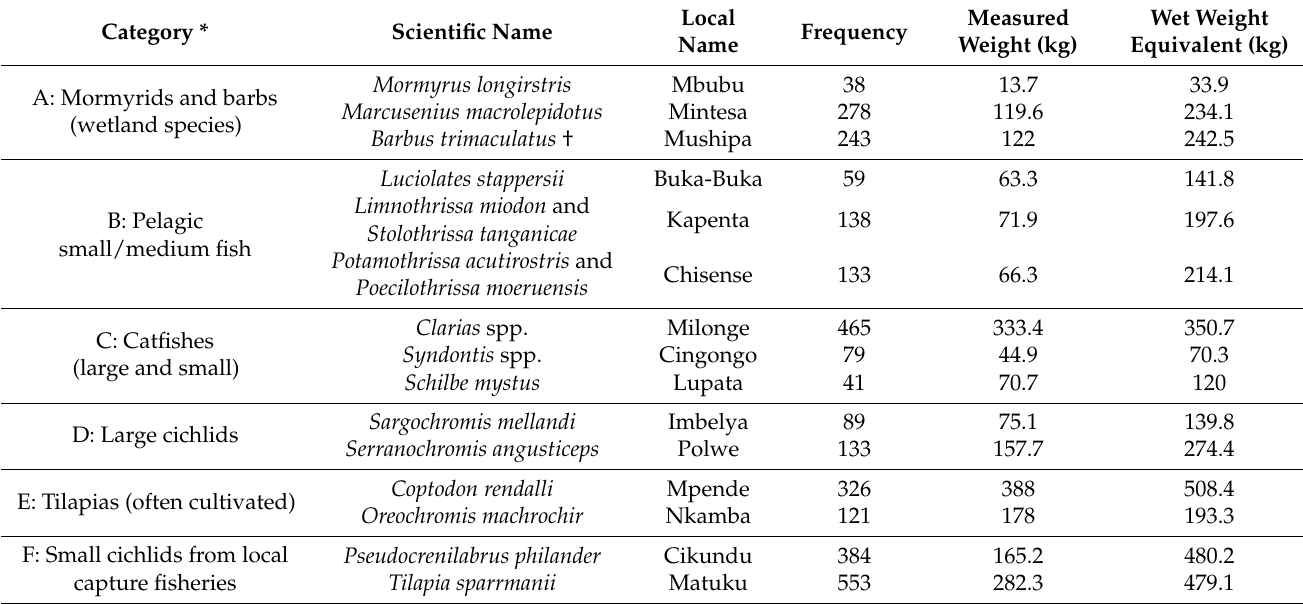
Table 3. Categories and names of the fish species consumed, including total frequency (number of times consumed) and total quantity (kilograms consumed), represented as the measured weight and wet weight